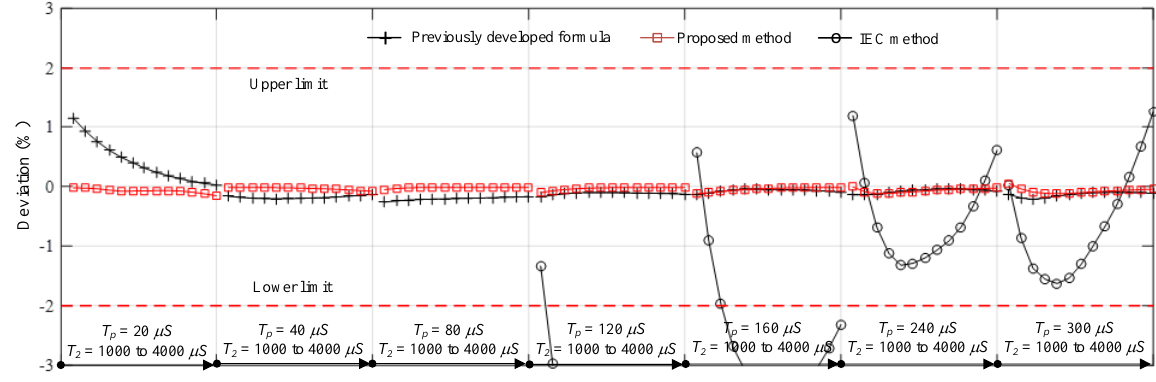
Figure 6. Zoom-in results of Figure 5.